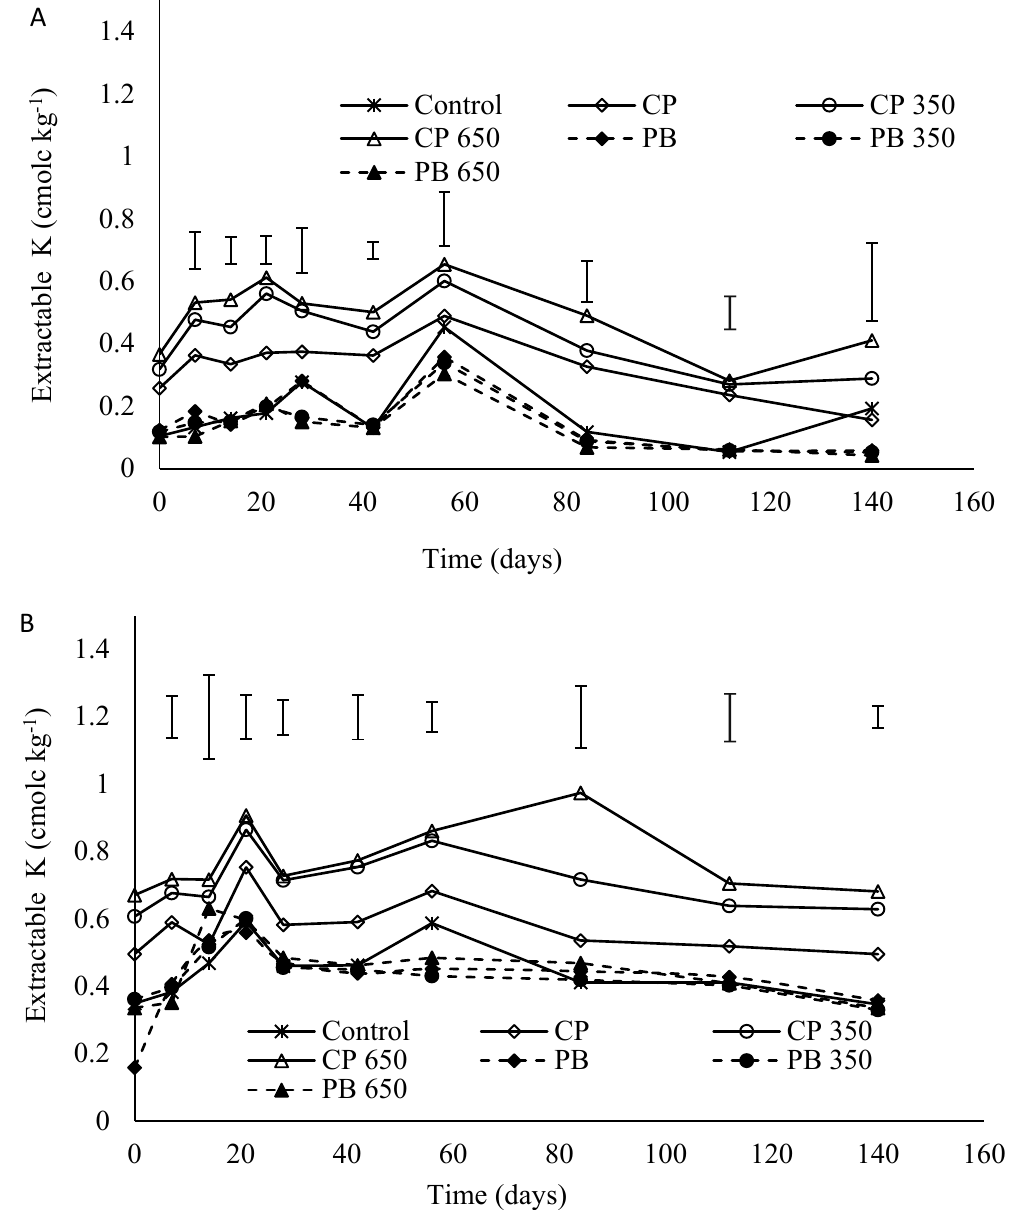
Figure 8. Concentrations of extractable K during incubation of Luvisol ( A ) and Ferralsol ( B ) amended with biochar from cull potato (CP) and pine bark (PB) produced at varying pyrolysis temperatures. CP = cull potato; PB = pine bark; CP 350 = cull potato biochar at 350 ◦ C; CP650 = cull potato biochar at 650 ◦ C; PB 350 = pine bark biochar at 350 ◦ C; PB 650 = pine bark biochar at 650 ◦ C. The vertical error indicates LSD ( p < 0.05).